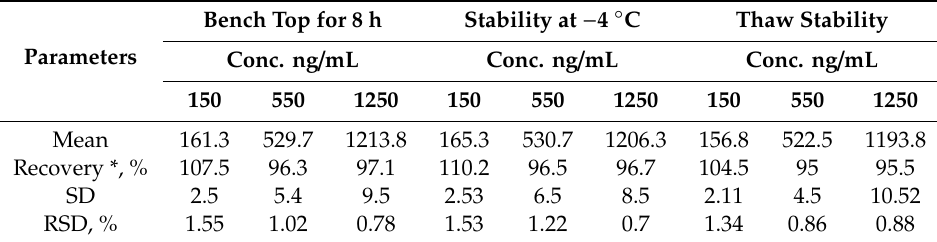
Table 6. Stability data of clonidine in mouse plasma.